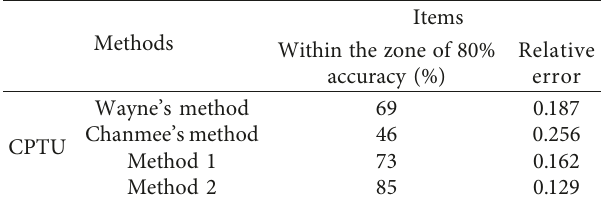
Table 3: Analysis and comparison results of four